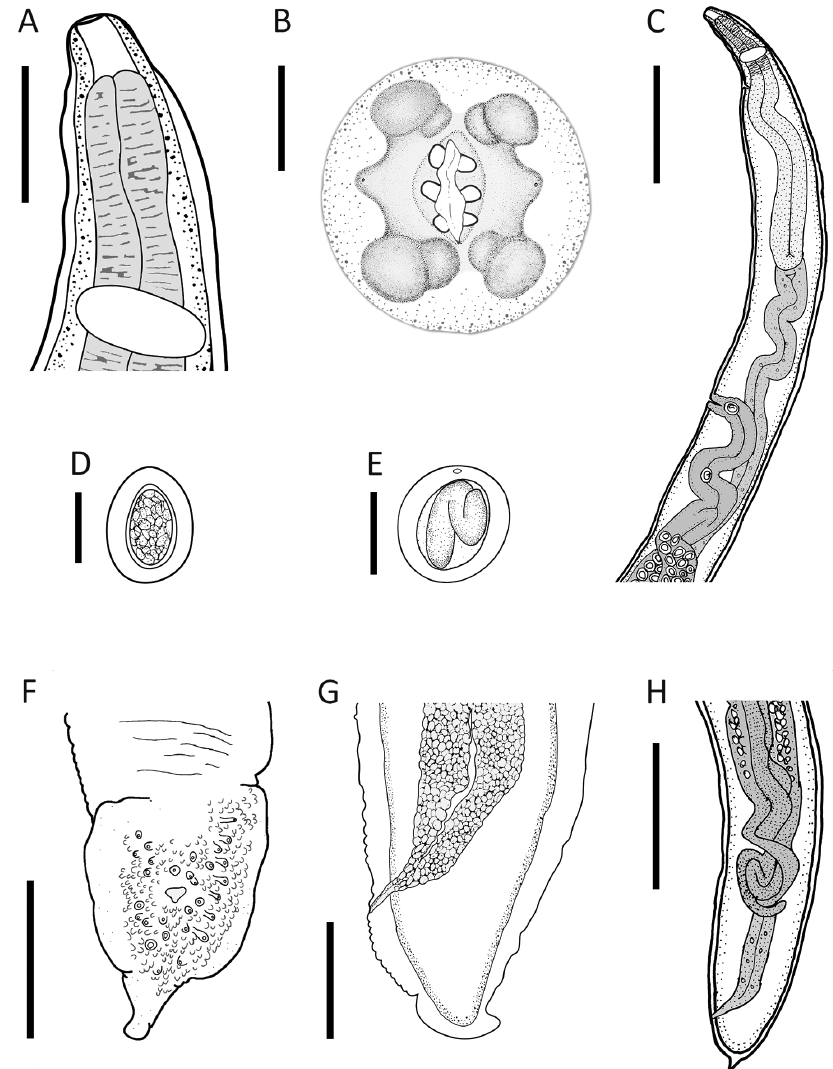
Figure 1. Thubunaea leonregagnonae sp. n. A Anterior end, female, lateral view B Apical view, female C Anterior end, female, lateral view showing excretory pore and vulva D Embryonated egg, lateral view E Larvated egg, lateral view F Caudal end, male, ventral view G Caudal end, male, lateral view, caudal papillae and ornamentation not shown H Caudal end, female, lateral view. Scale bars: A 90 µm; B 20 µm; C 370 µm; D 25 µm; E 30µm; F 250 µm; G 50 µm; H 370